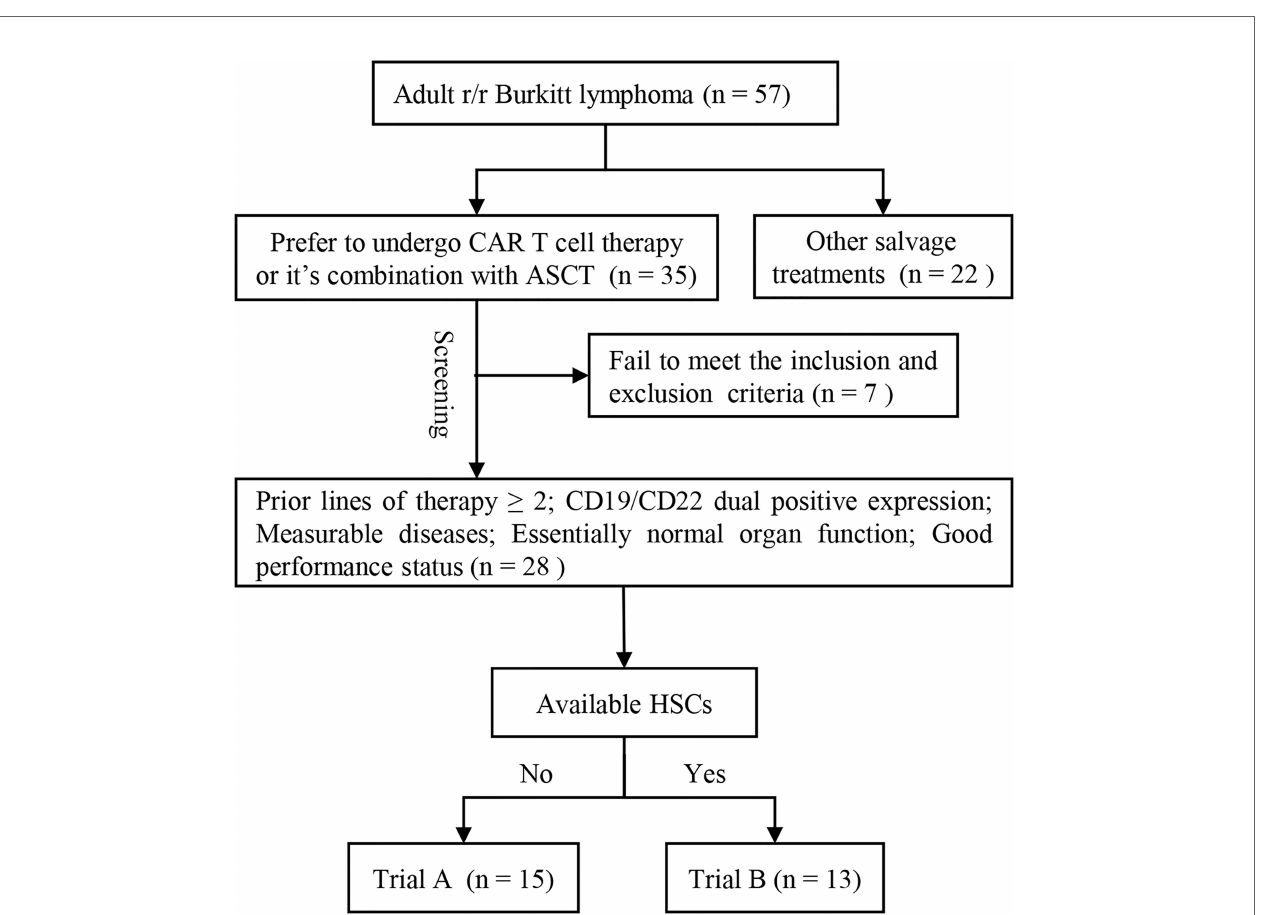
FIGURE 1 | Participant screening fl ow chart. Adult patients with r/r Burkitt lymphoma who opted to undergo CAR T cell immunotherapy or CAR T cell immunotherapy combined with ASCT entered the screening progress. All participants were r/r after prior treatments (therapy lines ≥ 2). The positive expression of CD19 and CD22 was con fi rmed via fl ow cytometry or immunohistochemical analysis. Measurable diseases, normal organ function, and good performance status were necessary for inclusion. Patients with uncontrollable infections were excluded. Patients with enough autologous HSCs were included in trial B and those without enough autologous HSCs were included in trial A. ASCT, autologous stem cell transplantation; CAR, chimeric antigen receptor; HSC, hematopoietic stem cell; r/r, refractory/relapsed; trial A, CD19/CD22 CAR T cell immunotherapy; trial B, CD19/CD22 CAR T cell immunotherapy following